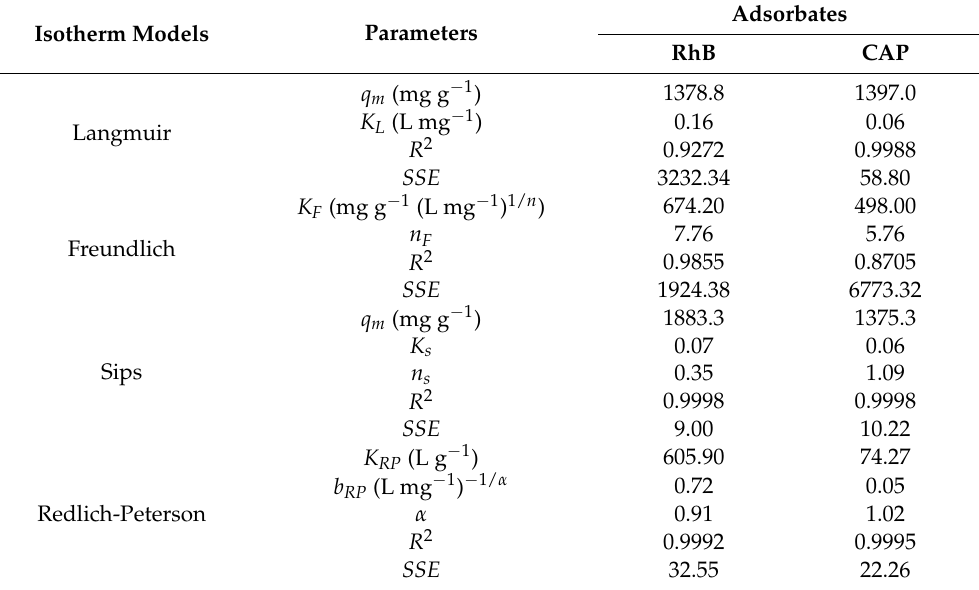
Table 1. Parameters of adsorption isothermal models for RhB and CAP adsorption on PCAC.